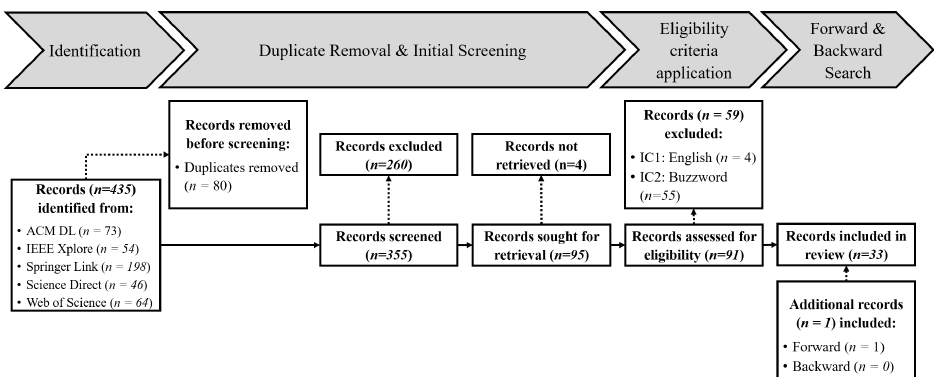
Figure 3. Flow chart of our literature identification process based on Page et al.